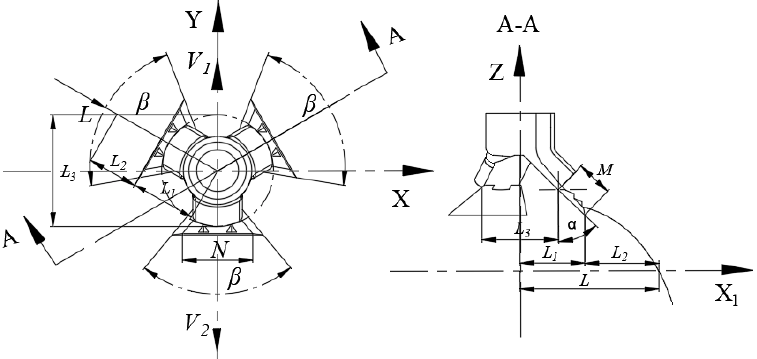
Figure 3. Analysis of fertilizer spreading campaigns.